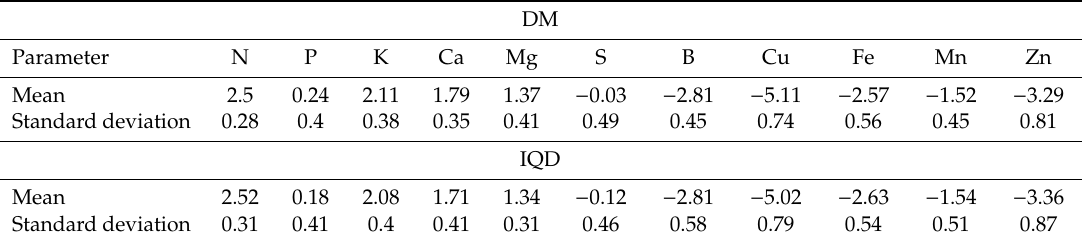
Table 5. CND guidelines for Eucalyptus spp. clonal rooted cuttings for the yield indicators whole plant dry matter (DM) and Dickson quality index (DQI).